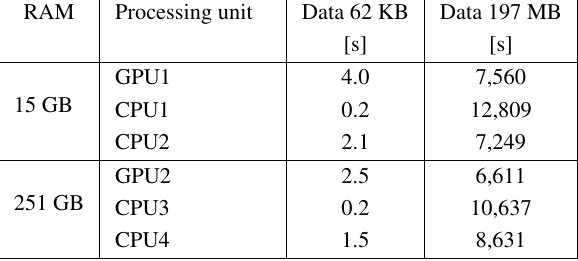
Table 1. Results of parallelization tests